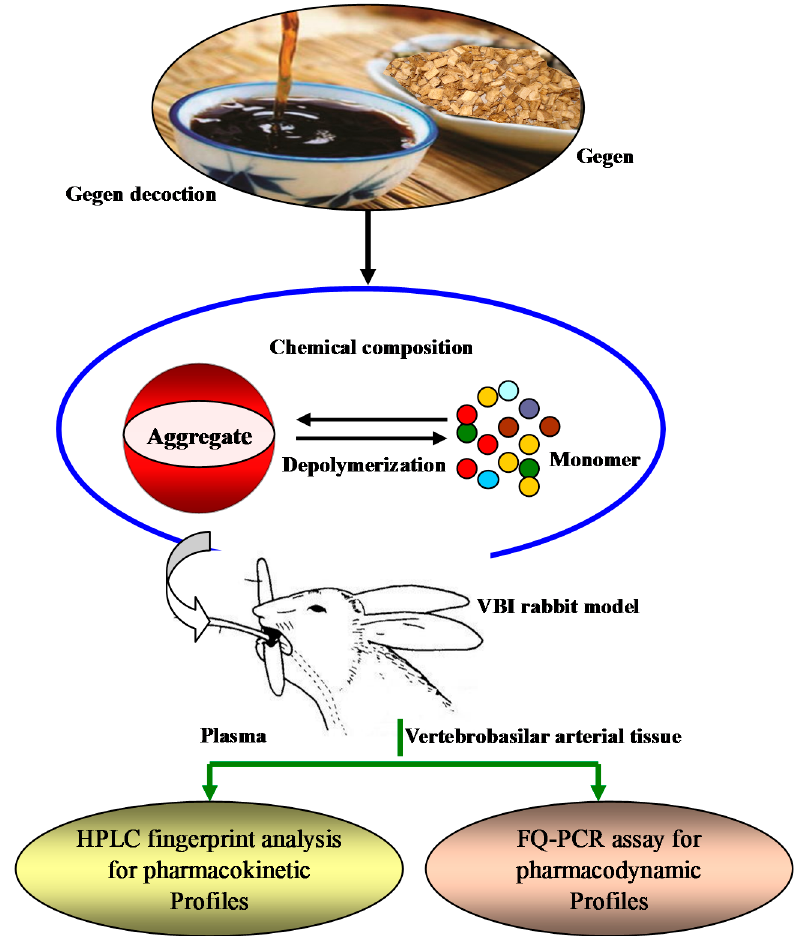
Figure 1. Diagram of the focus of this paper.